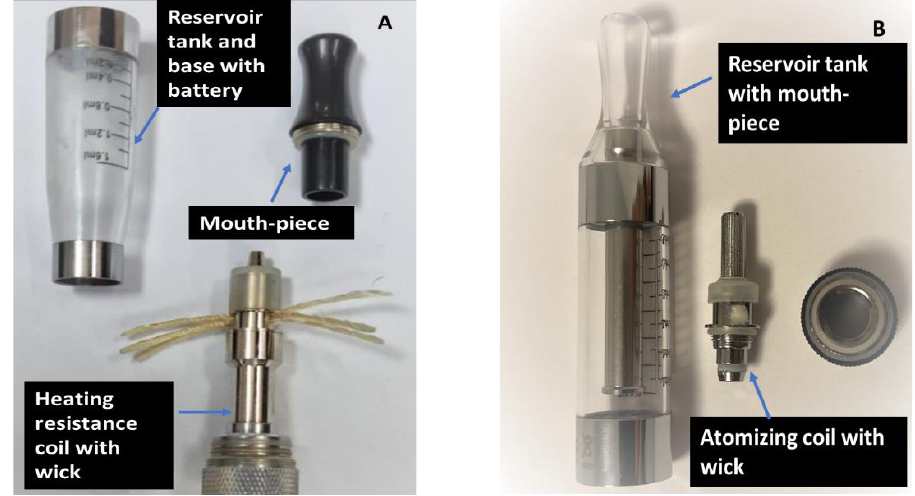
Figure 1. Anatomy of the clearomizers used in the experiment (( A ) clearomizer 1; ( B ) clearomizer 2).